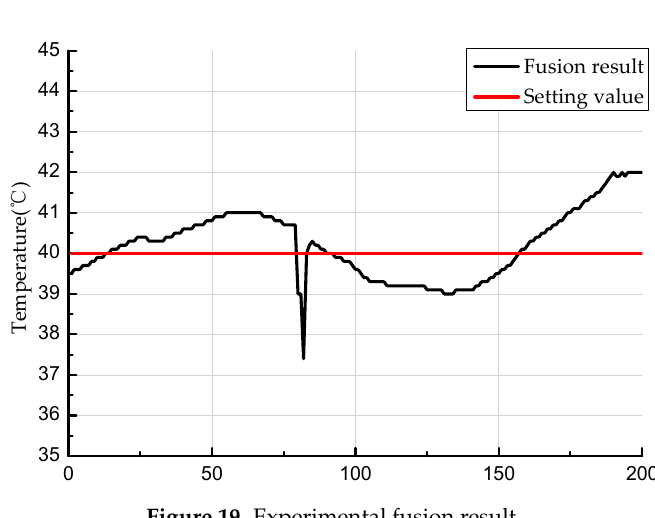
Figure 19. Experimental fusion result.